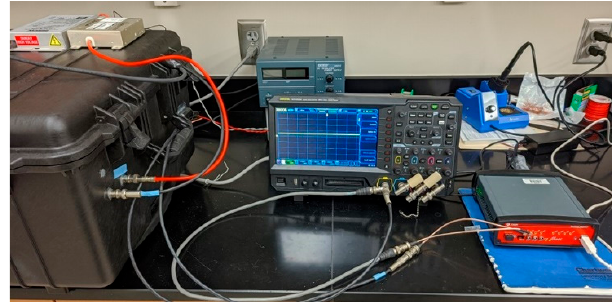
Figure 3. Full experimental setup showing the dark box and the ADC.